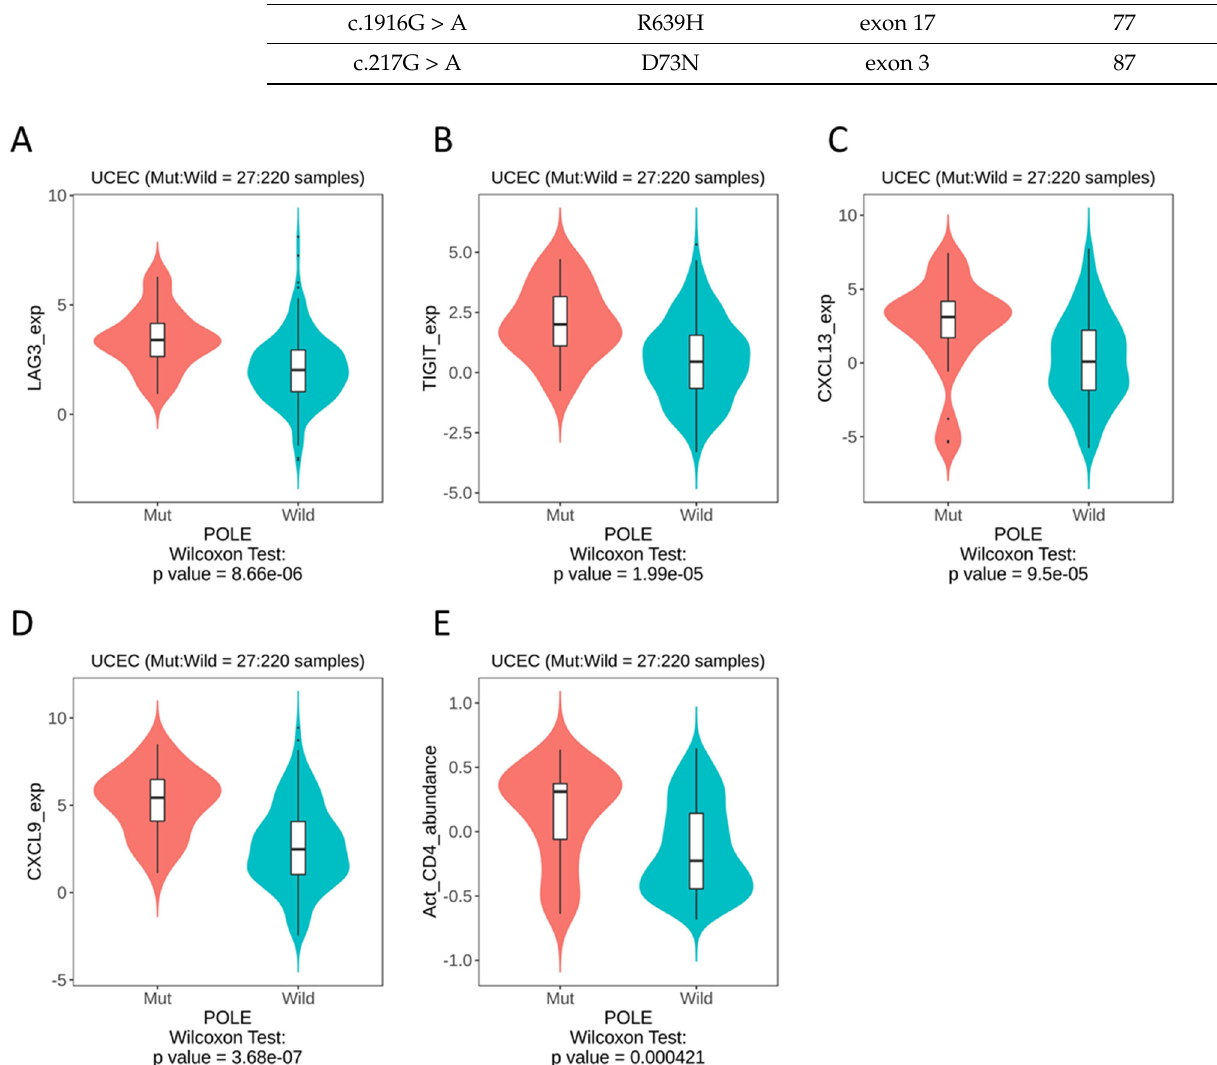
Figure 5. TISIDB datamining in UCEC, POLE mutation vs. wild-type, immune gene expression. ( A ) LAG3. ( B ) TIGIT. ( C ) CXCL13. ( D ) CXCL9. ( E ) Activated CD4 T cells.